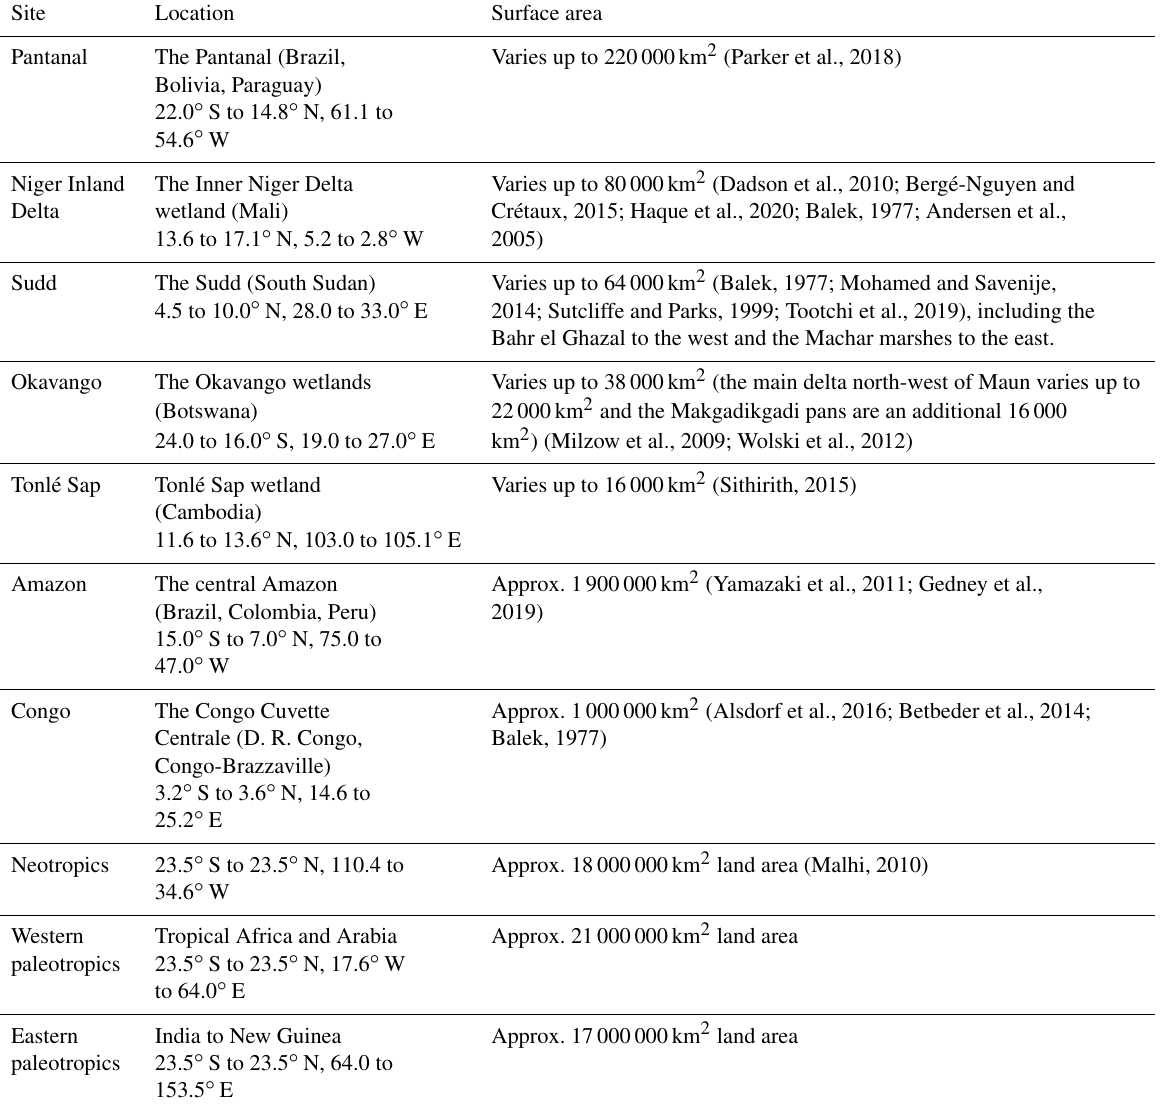
Table 1. The wetland case study areas. Total tropical land area is approx. 56000000km 2 (approx. 38% of total global land).